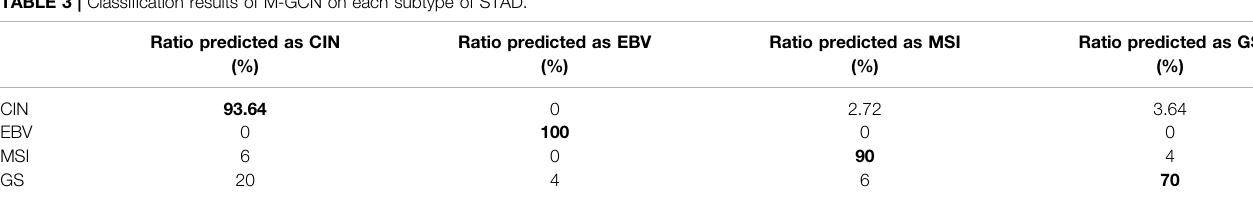
TABLE 3 | Classi fi cation results of M-GCN on each subtype of STAD. Ratio predicted as CIN